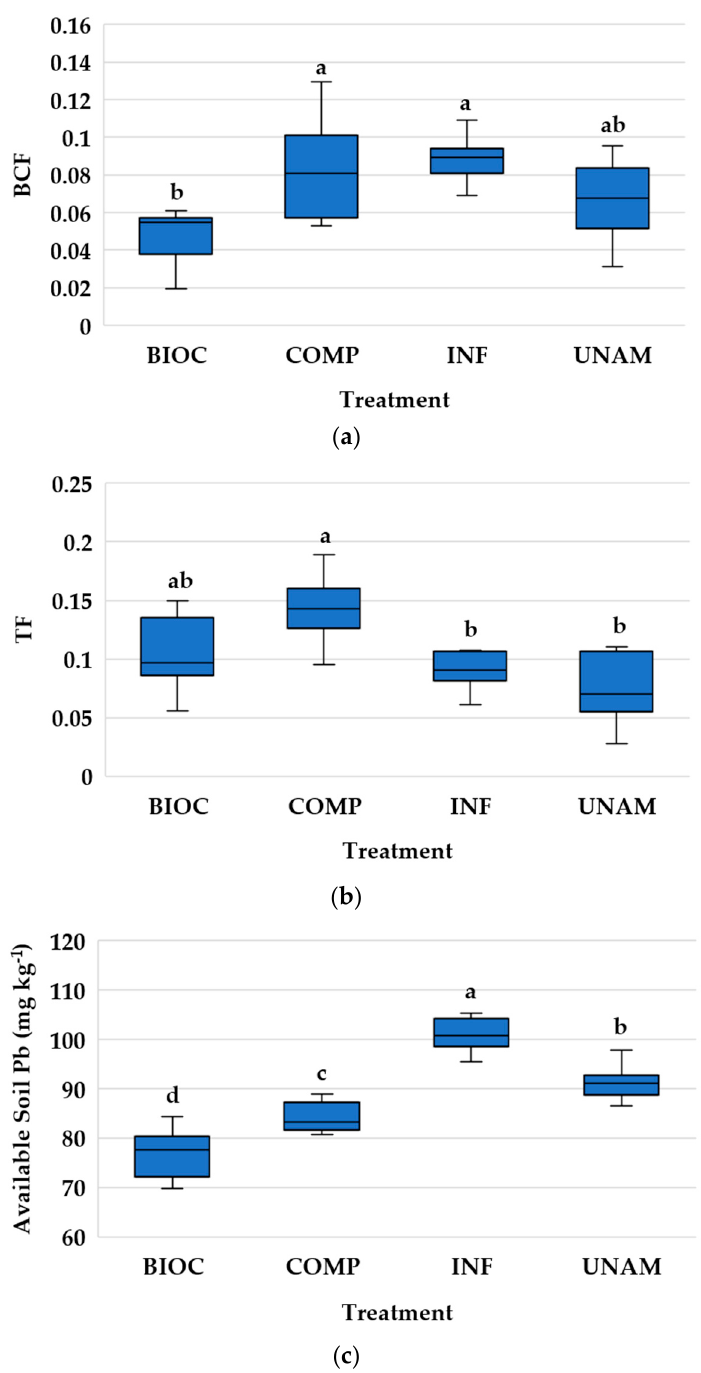
Figure 9. Lead uptake indicators and soil concentrations among radish samples: ( a ) bioconcentration factor (BCF); ( b ) translocation factor (TF); and ( c ) soil available lead (Pb) for radish grown in soils amended with biochar (BIOC), compost (COMP), inorganic fertilizer (INF) and unamended control (UNAM). Lowercase letters indicate statistically significant differences between treatments. Statistical tests were performed using a two-way Analysis of Variance (ANOVA) or Kruskal-Wallis if data could not be normalized. Tukey HSD and Dunn’s test (non-normal data) were used to determine treatment significance at a minimum of p ≤